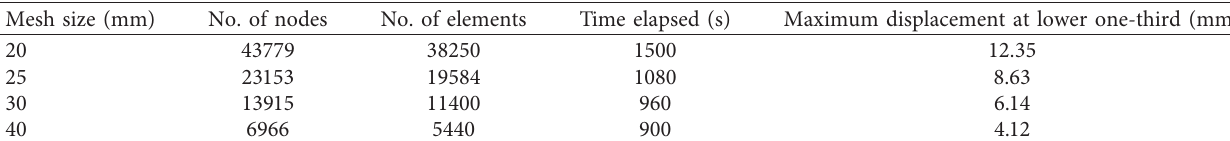
Table 8: Mesh sensitivity analysis.